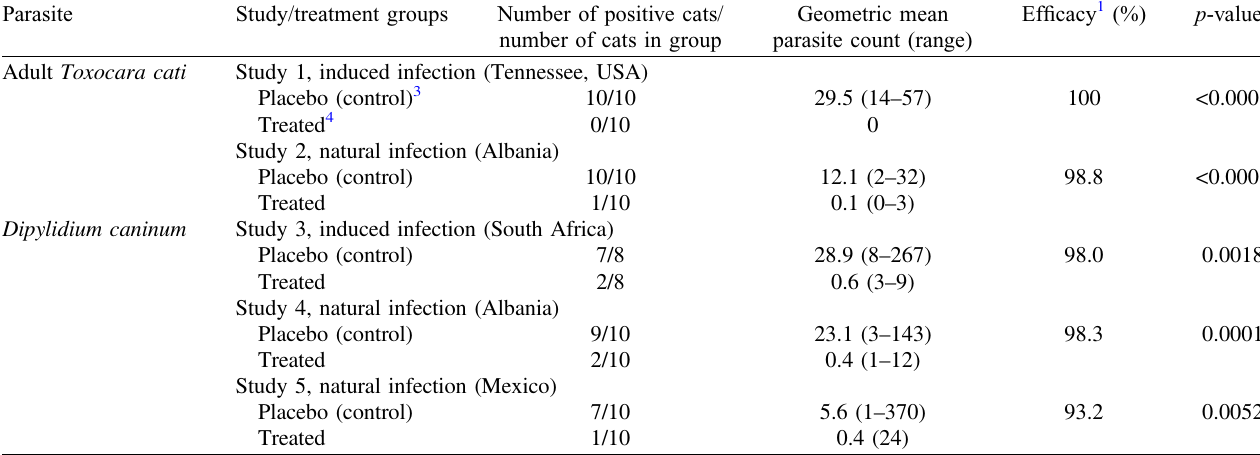
Table 3. Parasite counts and ef fi